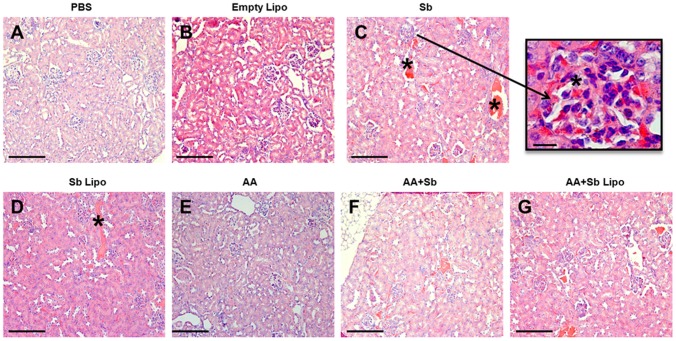
Histopathological analyses of the kidney from L. infantum infected mice submitted to different treatment regimens.(A) Phosphate-buffered saline (PBS). (B) Empty liposomes (Empty Lipo). (C) Trivalent antimony (Sb). (D) Antimony entrapped liposomes (Sb Lipo). (E) Ascorbic acid (AA). (F) Ascorbic acid in association with antimony (AA+Sb). (G) Ascorbic acid in association with antimony entrapped liposomes (AA+Sb Lipo). Bar  = 50 µm. Insert  = 25 µm, representing glomerular hyperemia. (A), (B) and (E) renal parenchyma exhibiting normal aspect. (C), (D), (F) and (G) renal parenchyma exhibiting active hyperemia. * Hyperemic vessels.